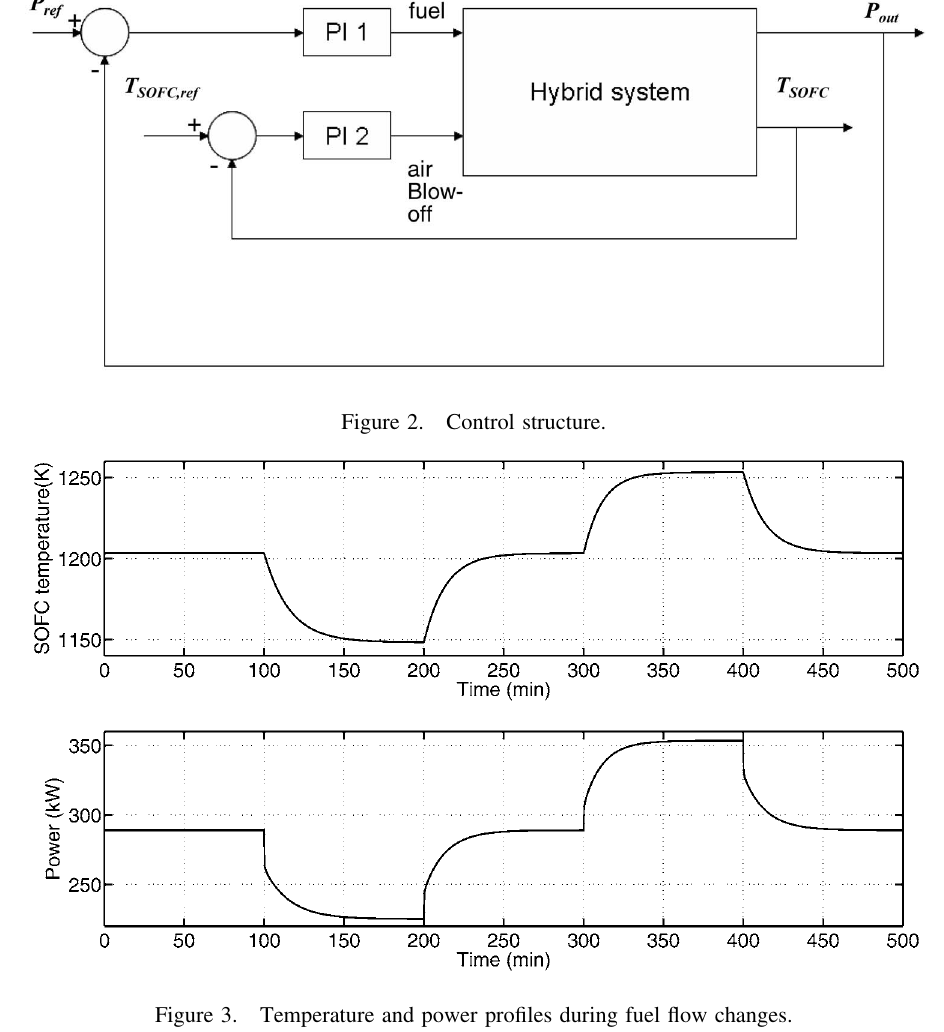
Figure 3. Temperature and power profiles during fuel flow